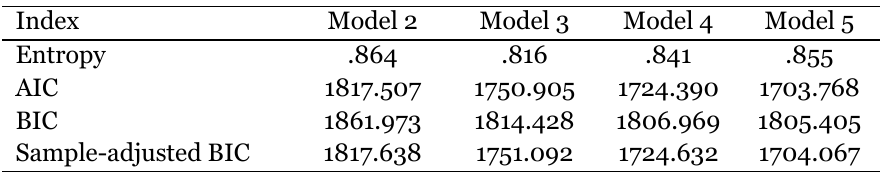
Goodness of Fit and Classification Precision by